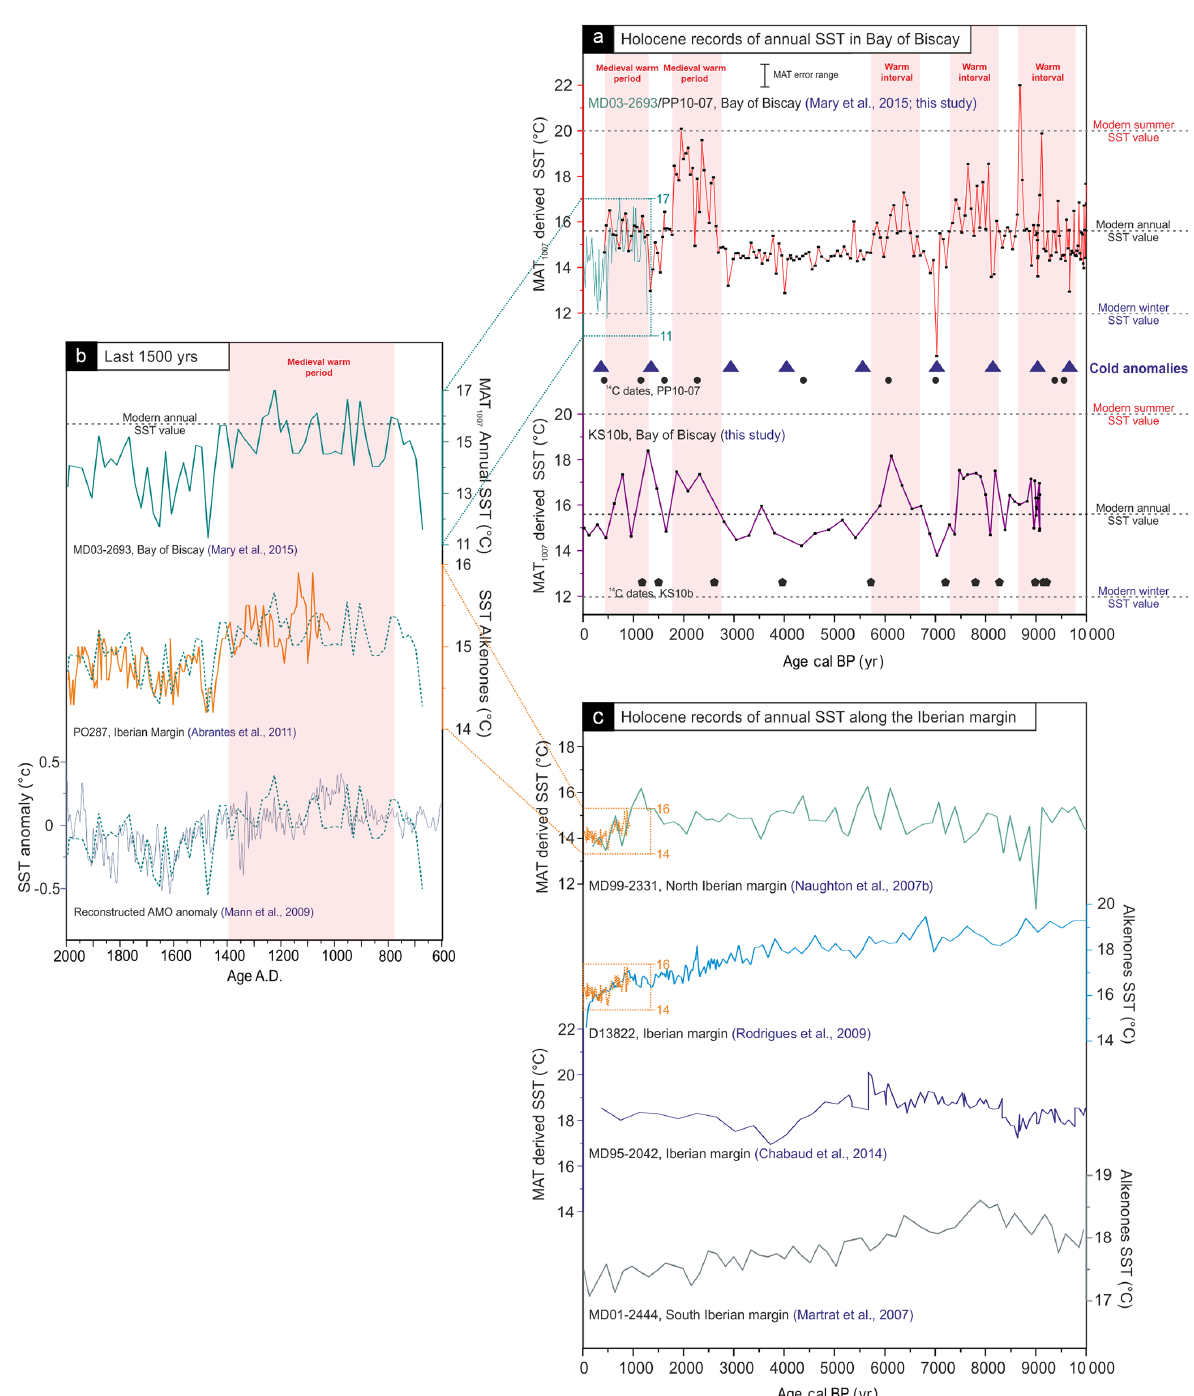
Figure 3. Mean annual sea surface temperature (SST) records from the western European margin. (a) Holocene SST signals from cores PP10-07 and KS10b (this study) reconstructed using the modern analogue technique (MAT) based on planktonic foraminifera (see Sect. 2, Methods), and compared to SST signal of the adjacent core MD03-2693 (Mary et al., 2015). Black dots identify 14 C age control points. (b) SST signals spanning the last 1500 years in the Bay of Biscay (core MD03-2693) based on MAT and from the Iberian margin (core PO287-06; Abrantes et al., 2011) using alkenones. Reconstructed signals are compared with the AMO reconstruction of Mann et al. (2009). The dotted curve represents core MD03-2693 signal transposed on top of the two other curves. (c) Holocene SST signals from the Iberian margin using MAT based on planktonic foraminifera for cores MD99-2331 (after Naughton et al., 2007b) and MD95-2042 (after Chabaud et al., 2014) and alkenones for cores D13882 (after Rodrigues et al., 2009) and MD01-2444 (after Martrat et al.,